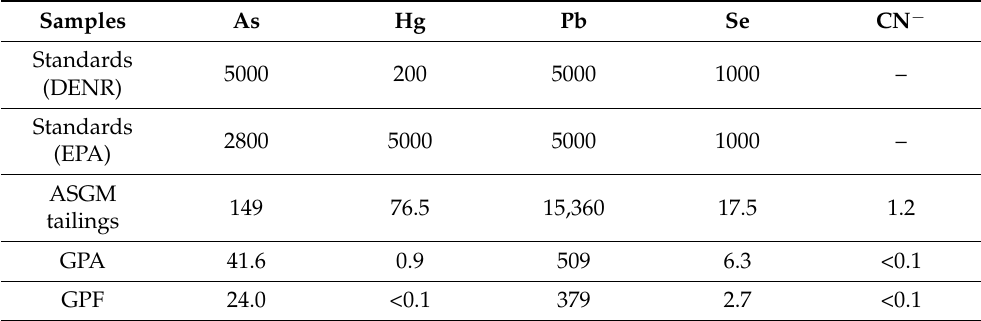
Table 4. TCLP leachability characteristics of ASGM tailings and synthesized geopolymer composites ( µ